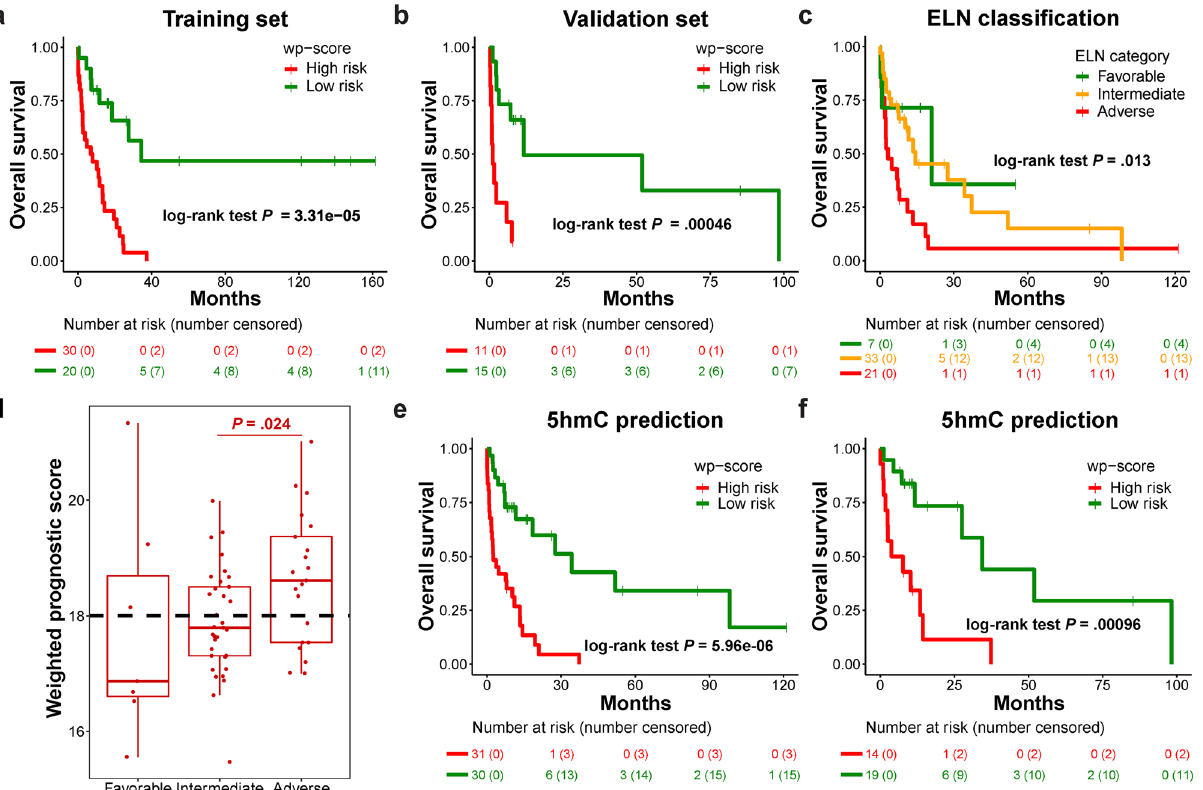
Figure 3. A 5hmC signature predicts overall survival in AML patients. ( a ) Kaplan–Meier analysis of overall survival of AML patients in training set based on wp-scores (n = 50). ( b ) Kaplan–Meier analysis of overall survival of AML patients in validation set based on wp-scores (n = 26). ( c ) Overall survival analysis of 61 AML patients with cytogenetic and/or molecular genetic information following the European LeukemiaNet (ELN) risk classification. ( d ) Association of wp-score with risk stratification of the 61 AML patients categorized using ELN classification. Favorable, n = 7; Intermediate, n = 33; Adverse, n = 21. Black dashed line represents a cutoff wp-score of 18.0 developed from training set. Center line represents median, bounds of box represent 25th and 75th percentiles, and whiskers are Tukey whiskers. ( e ) Overall survival analysis of the 61 AML patients with cytogenetic and/or molecular information available based on wp-scores. ( f ) Wp-score further stratifies patients in the intermediate group (n = 33) categorized by ELN